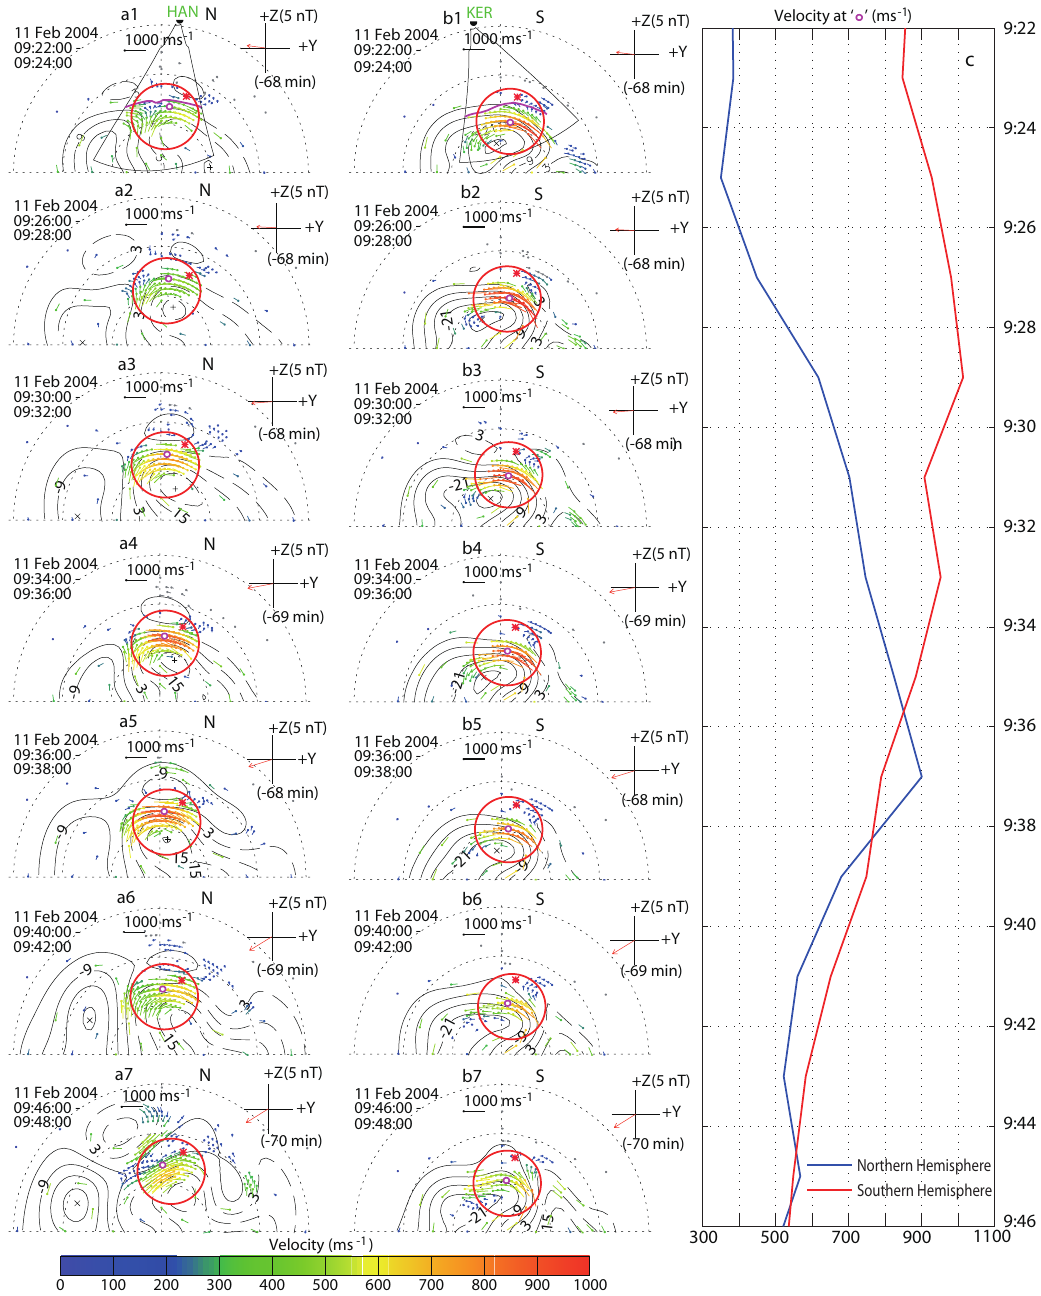
Fig. 10. Streamlines and vectors of the dayside ionospheric flows derived from the Northern (a1–7 and d1–6) and Southern (b1–7 and e1–7) Hemispheric SuperDARN velocity measurements shown on geomagnetic grids, obtained from the “map potential” algorithm. Maps are shown for (a) from 09:22 to 09:46UT and for (b) from 11:18 to 11:48UT. The field-of-view of the CUTLASS Finland radars (HAN) and Kerguelen radar (KER) are presented as a fan in panel a1 (d1) and b1 (e1), respectively. The direction and magnitude of the lagged IMF are indicated at the right-hand upper corner of each map. The red star and blue circle represents the ionospheric footprint of TC-1 (in panels a1–7 and b1–7) and Cluster S/C 1 (in panels c1–6), respectively. The time series of ionospheric flow velocity, which are extracted from the convection maps at the violet circle in panels (a) and (b) and the violet rhombus in panels (d) and (e) , are presented in panels (c) and (f) ,